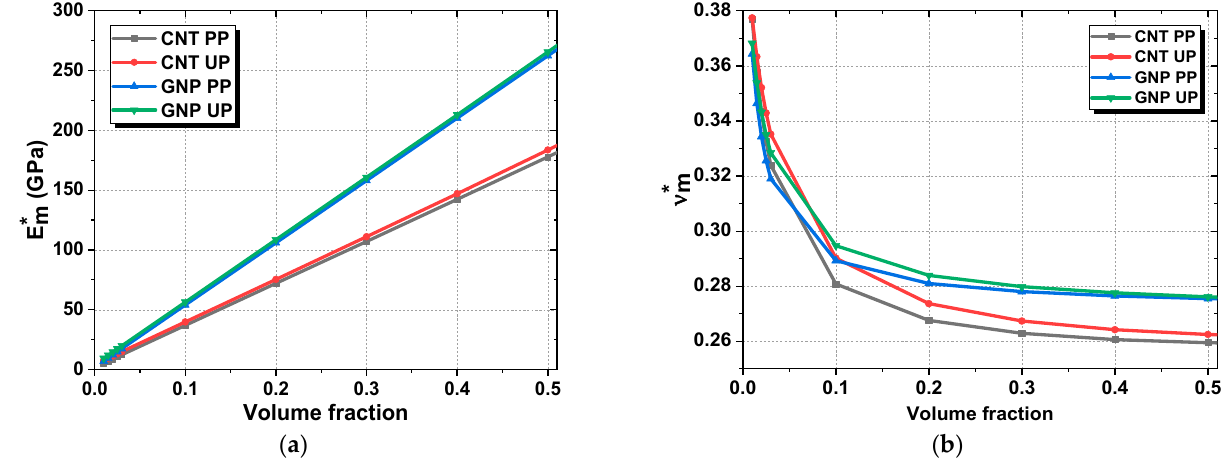
Figure 5. Comparison of the effective elastic moduli of a matrix reinforced by randomly oriented nanofillers, by using numerical method with Digimat MF: ( a ) effective Young’s modulus E ∗ m ; and ( b ) effective Poisson’s ratio ν ∗ m